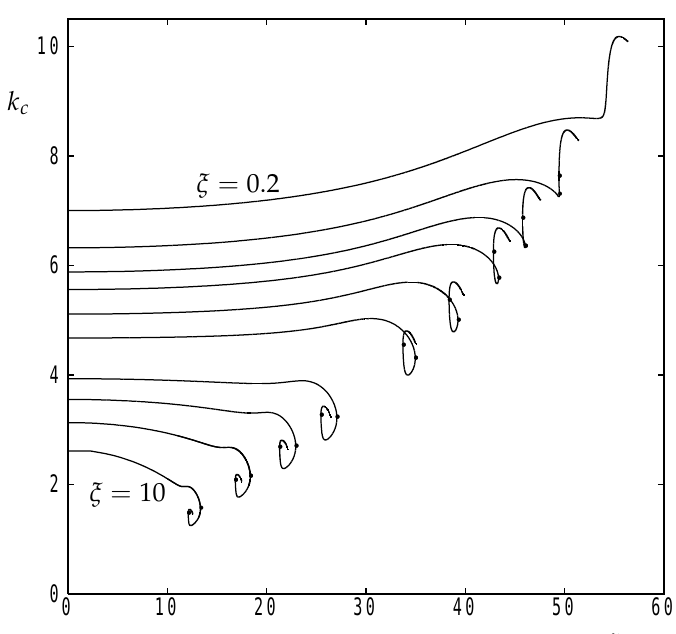
Figure 4. Showing the variation of k c for transverse roll disturbances at critical points on the neutral curve for ξ = 0.2 (uppermost), 0.3, 0.4, 0.5, 0.7, 1, 2, 3, 5 and 10 (lowest). The black disks correspond either to isola points or to saddle points.